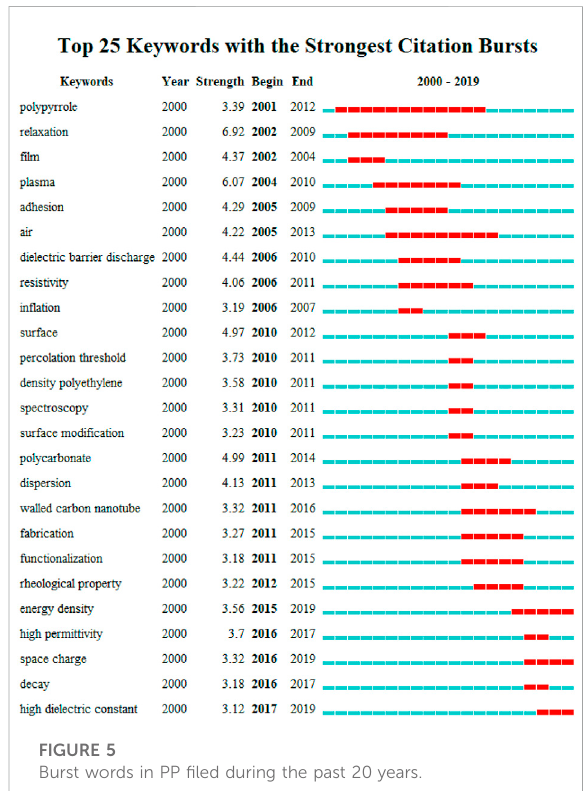
FIGURE 5 Burst words in PP fi led during the past 20